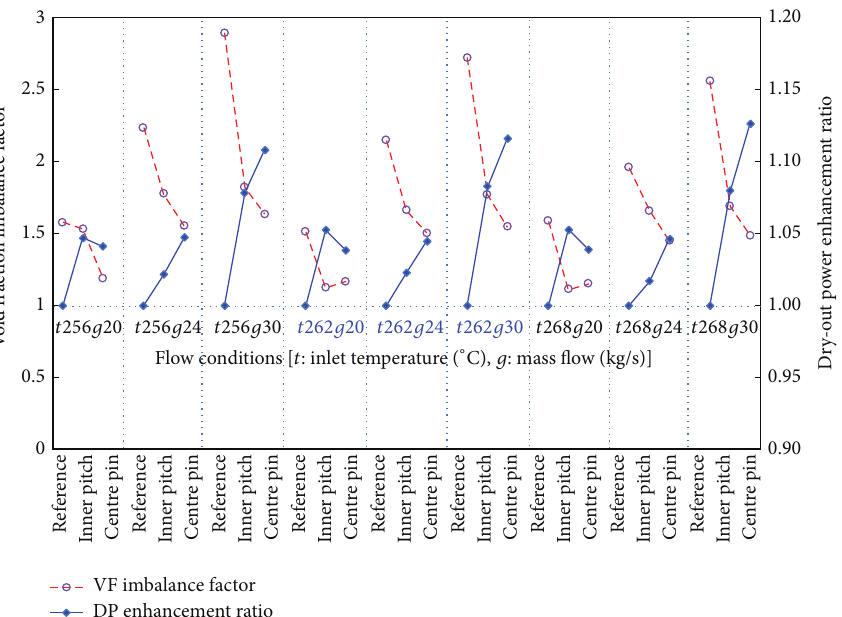
Figure 13: Comparison of void fraction imbalance factors and dry-out power enhancement ratioaccording to the flow